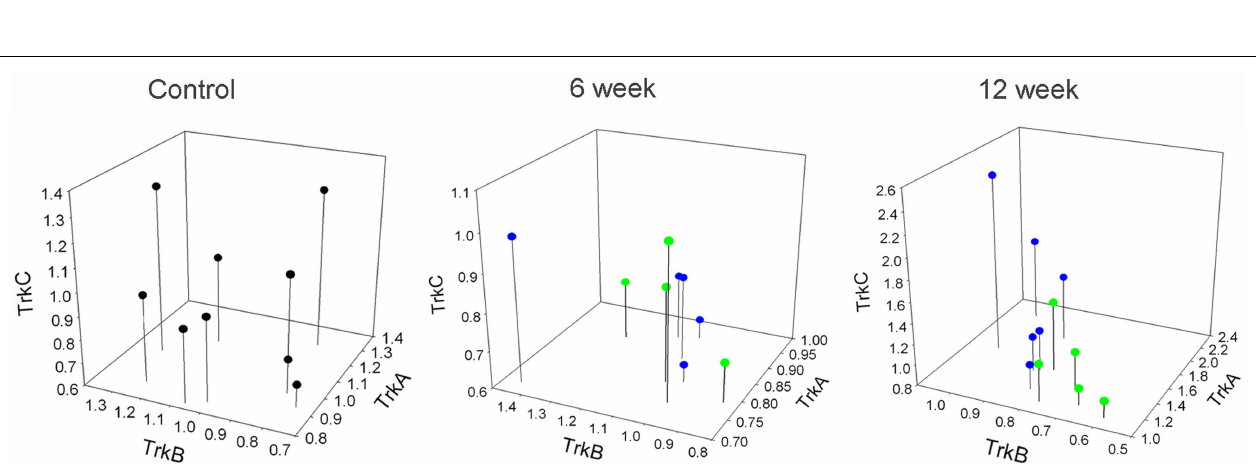
FIGURE 6 | Correlated expression of neurotrophins in DRG emerges at chronic time points. Values represent fold-change of the individual animals vs. mean of control group. Blue dots represent animals with 12.5gcm injuries. Green dots represent animals with 25gcm injuries.